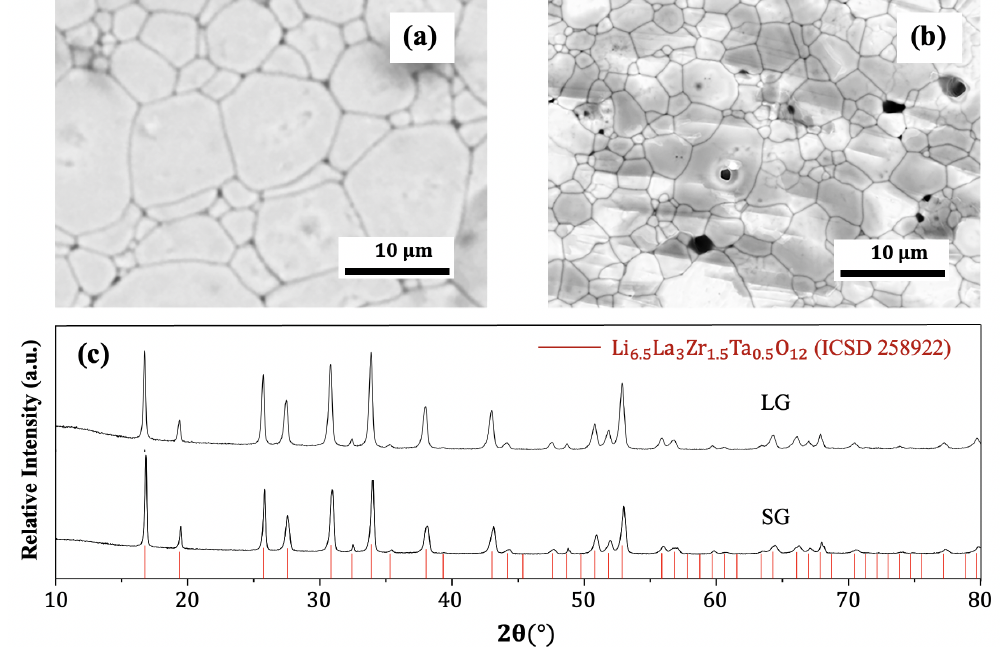
Figure 3. SEM images of the pellets with ( a ) larger grains (LG) and ( b ) smaller grains (SG). The visible surface pores are removed by polishing before further processing. The corresponding ( c ) XRD patterns of the pellets are compared with the cubic phase of Li 6.5 La 3 Zr 1.5 Ta 0.5 O 12 , calculated from the results of Awaka et al.